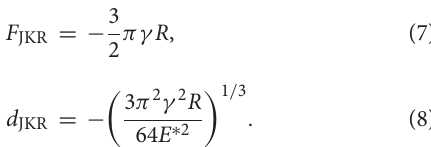
“contact radius” is formally defined as a ∗ full contact we have a ∗ 1.77, so the value of 1.77 in x-axis of Figure 2 indicates